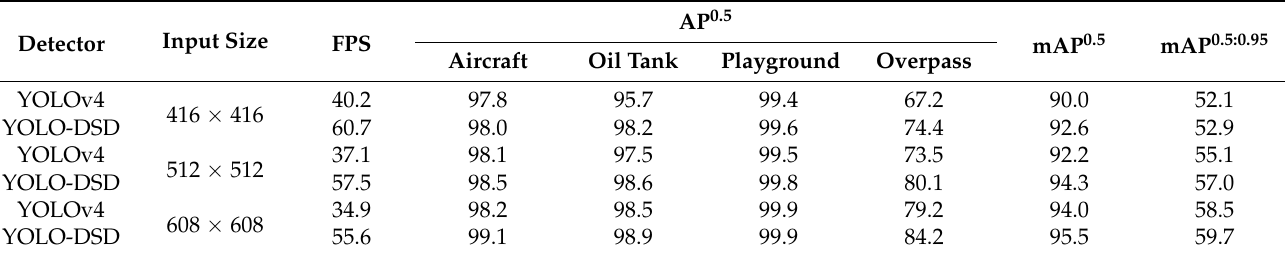
Table 10. Results of comparative experiment for YOLOv4 and YOLO-DSD in